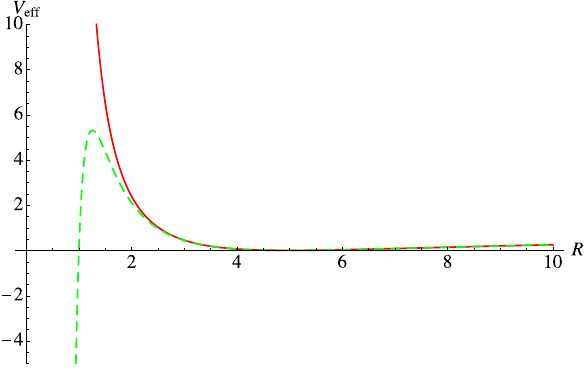
Fig. 2 The effective potential V ef f in Eq. (50) for timelike ( k = − 1) radial ( L = 0) geodesics for m / R c = 5 as a function of R / R c . The solid (red) curve represents the case s = + 1 while the dashed (green) curve is for s = − 1. Note that in this figure the wormhole throat is located at R = R c = 1, where V − ef f